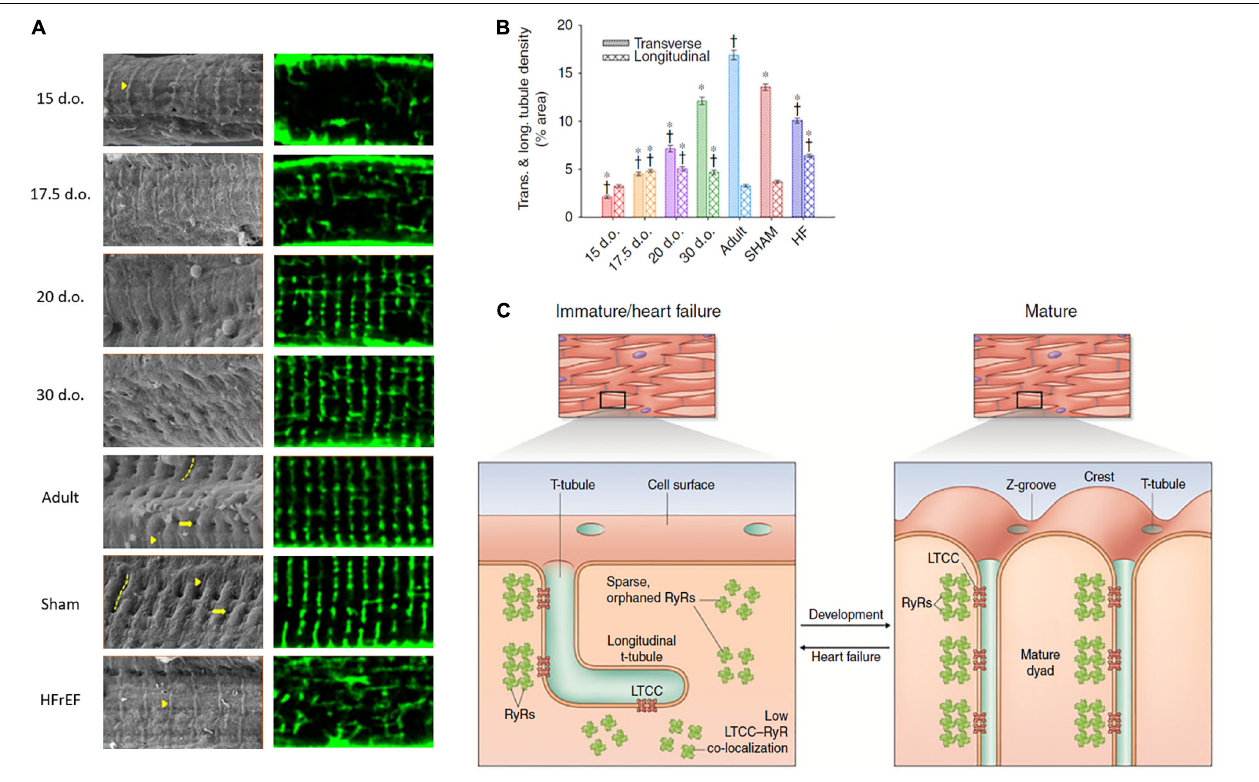
FIGURE 2 | Changes in cardiomyocyte surface topography and dyadic organization in the developing and HFrEF rat heart. (A) Left panels: Scanning electron micrographs show the appearance of Z-spines (arrowheads) from an early time point during development and their re-appearance during post-infarction HFrEF. Z-grooves (dashed lines) and t-tubule openings (arrows) appear gradually during development and are lost in HFrEF. Right panels: temporally matched confocal captures of internal t-tubules (di-8-ANEPPS staining). (B) Quantification of these t-tubule signals illustrates an organizational shift from a predominantly longitudinal to largely transverse orientation during maturation, but reversion to an immature phenotype during HFrEF. (C) Structural parallels between developing and failing myocytes include not only t-tubule structure, but also similarly sparse arrangements of RyRs that exhibit low co-localization with LTCCs. d.o., days old. * P < 0.05 vs. adult in same category, † P < 0.05 vs. SHAM in same category. Reproduced from Lipsett et al. (2019) with